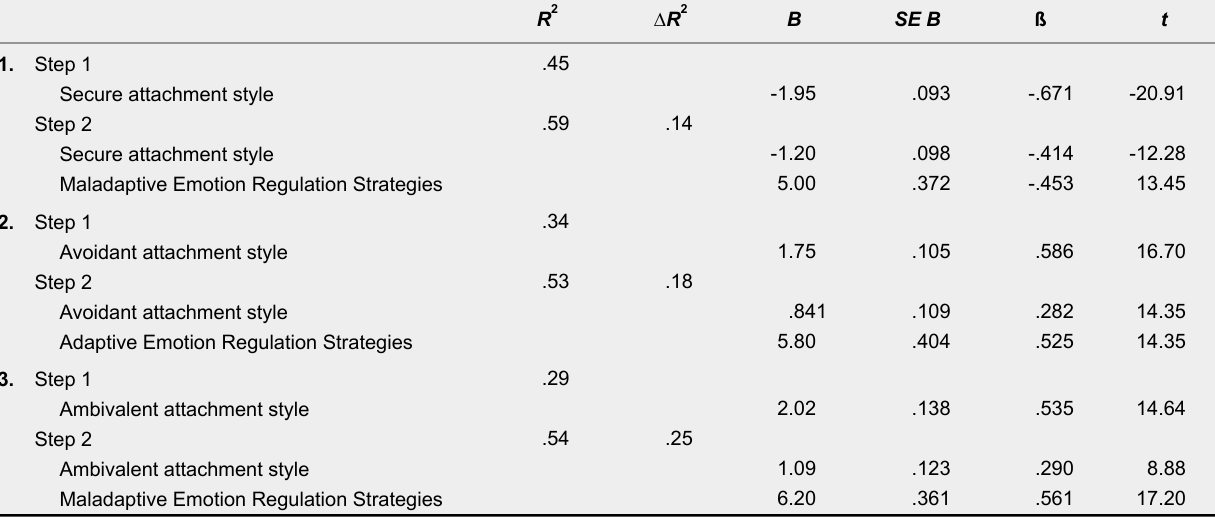
Summary of Regression Analyses for Mediating Role of Maladaptive Emotion Regulation Strategies between Attachment Styles and